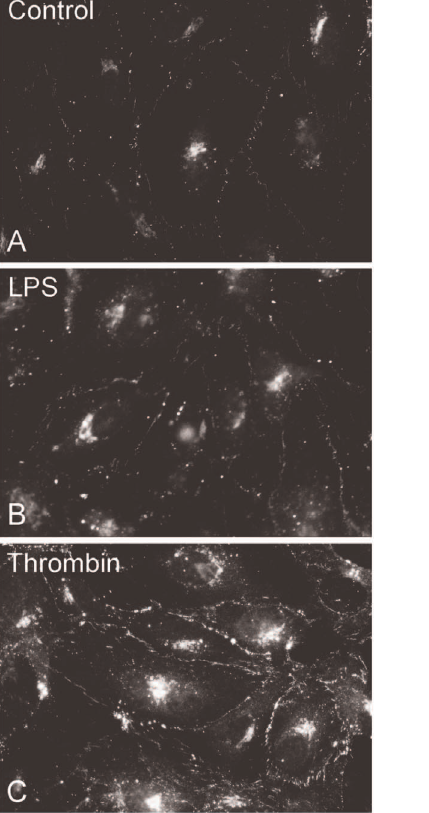
Figure 3. Cx43 distribution between appositional membranes and cytoplasm is unaffected by thrombin or LPS treatment. HPAECs were grown to confluence on glass cover slips and left untreated (A, Control) or treated with LPS (B, 200 ng/mL for 24 hr) or chronic thrombin (C, 0.25 U/mL hourly for 6 hrs). Then, cells were subjected to indirect immunofluorescent staining using a Cx43 antibody.